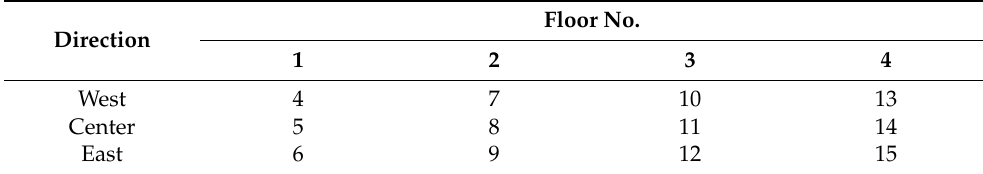
Table 1. ASCE problem: sensor numbering and locations [19].